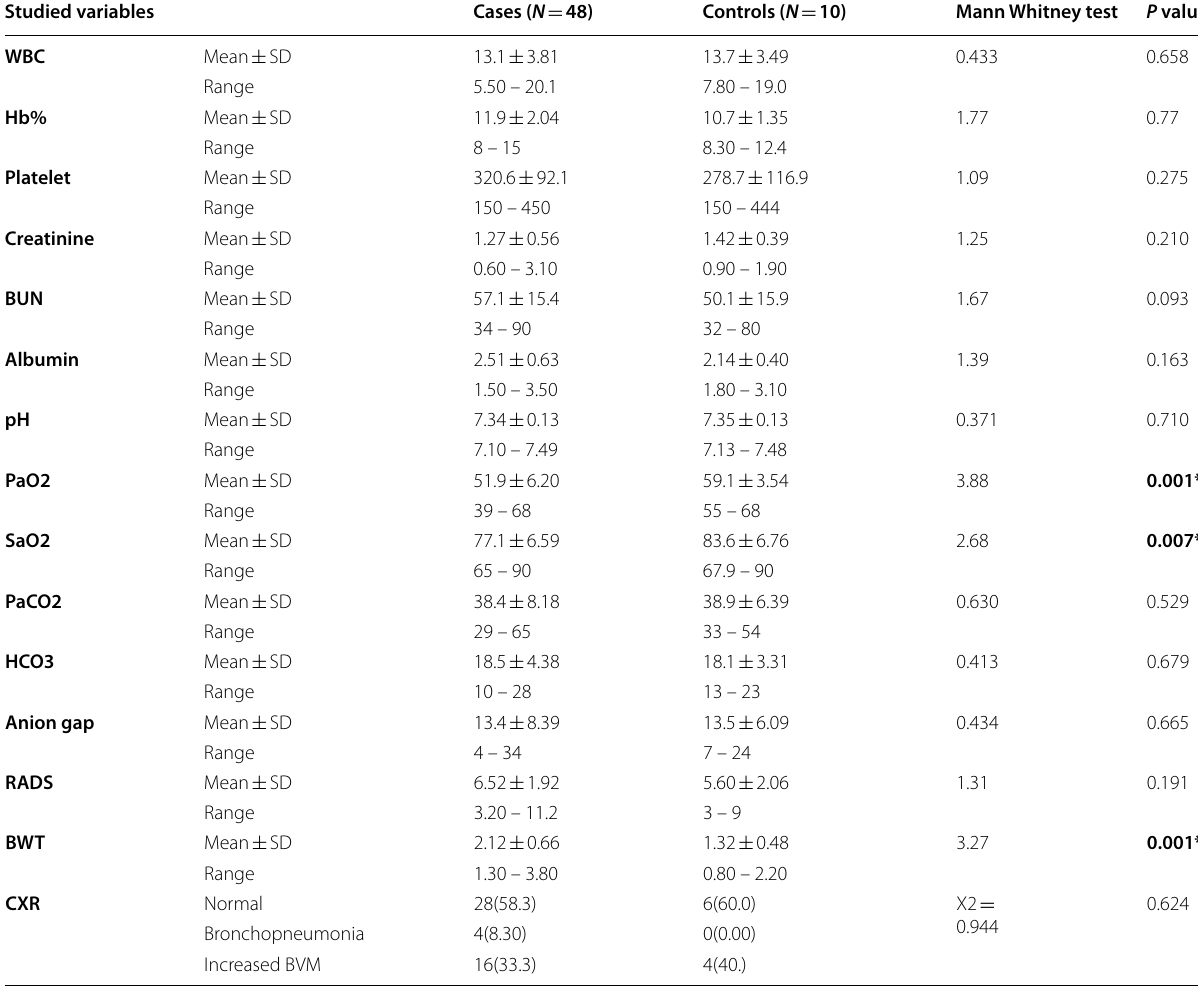
Table 3 Laboratory & radiological findings on